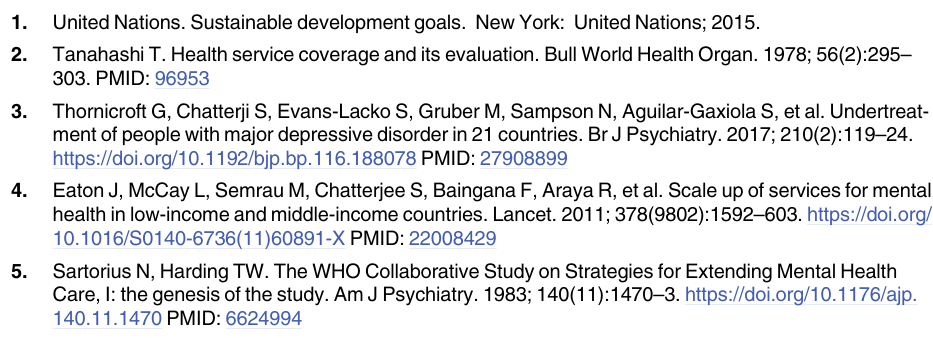
S1 Table. Decision criteria for minimally adequate treatment. S2 Table. Reasons for loss to follow-up in the cohort studies.